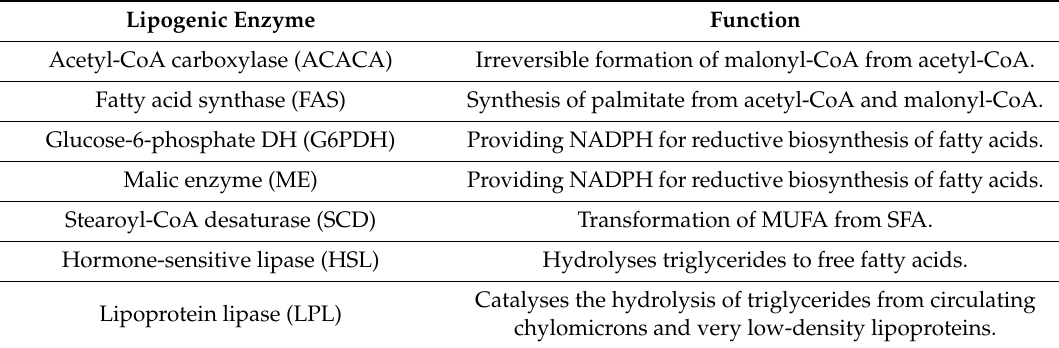
Table 1. The function of lipogenic and lipolytic enzymes in adipose tissue [32]. Lipogenic Enzyme Function Irreversible formation of malonyl-CoA from acetyl-CoA. Synthesis of palmitate from acetyl-CoA and malonyl-CoA. Providing NADPH for reductive biosynthesis of fatty acids. Providing NADPH for reductive biosynthesis of fatty acids. Transformation of MUFA from SFA. Hydrolyses triglycerides to free fatty acids. Catalyses the hydrolysis of triglycerides from circulating chylomicrons and very low-density lipoproteins.